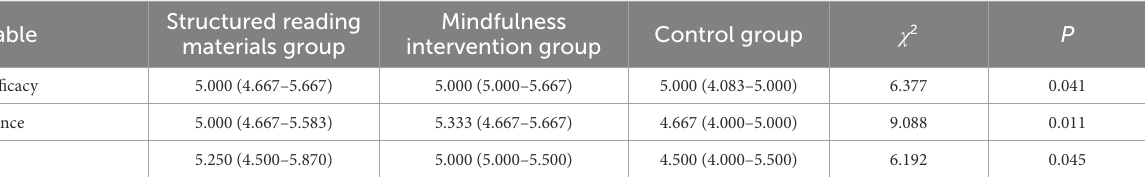
TABLE 7 Kruskal–Wallis test ( P 25 , P 50 , P 75